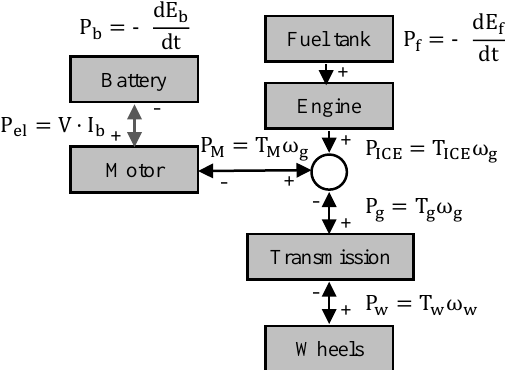
Figure 2. System layout, nomenclature and sign criteria for the parallel HEV architecture considered in this